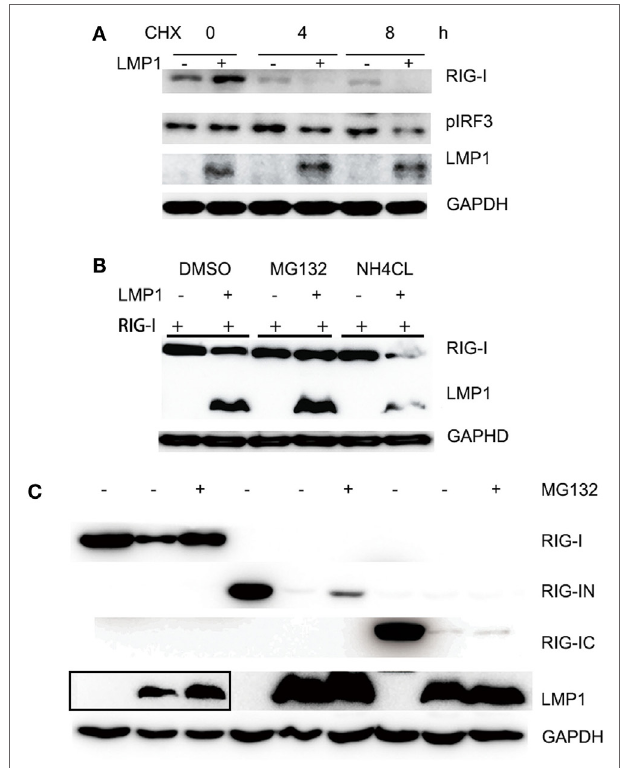
FigUre 2 | LMP1-promotes degradation of RIG-I and MG132 inhibited RIG-I degradation. (a) Immunoblot analysis of endogenously induced RIG-I and phosphorylated IRF3 in CNE2 cells. CNE2 were transfected with pCMV- LMP1 (empty vector as control) for 24 h, then infected with Sendai virus for 4 h, after infection, CNE2 was treated with CHX (100 mg/ml) for 3 h, RIG-I and pIRF3 of cell lysates were analyzed with Western blot. (B) Immunoblot analysis of FLAG tagged RIG-I in 293T cell lysates, which were transfected with pCMV-LMP1 (empty vector as control) and pcDNA-FLAG-RIG-I for 16 h, then treated with MG132 or NH4CL for 3 h. (c) FLAG tag was probed for immunoblot analysis of RIG-I and its N terminal and C terminal truncates in 293T cell lysates, which were co-transfected with FLAG-RIG-I/RIG-IN/RIG-IC and pCMV-LMP1 (vector as control) for 16 h, then treated with MG132 for 3 h. The Myc-LMP1 line was from two images, which were pictured from the same polyvinylidene difluoride film with different exposure time, the box area exposure time was longer than the right